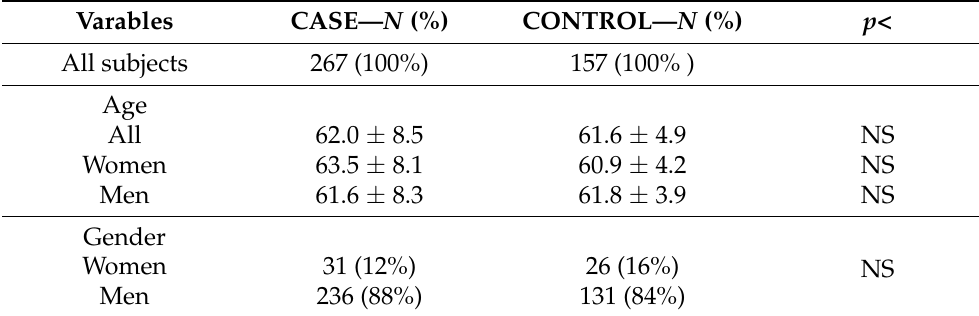
Table 1. Selected characteristics in laryngeal cancer cases and controls.